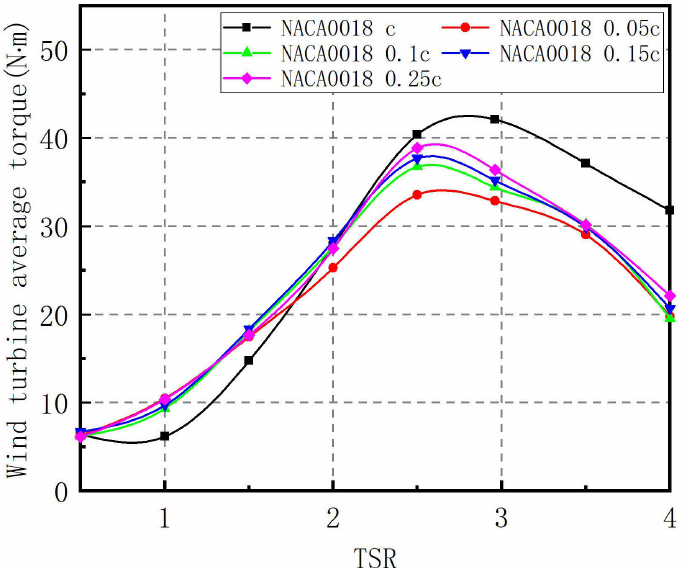
Figure 28. Curve of blade average torque changing with blade tip speed